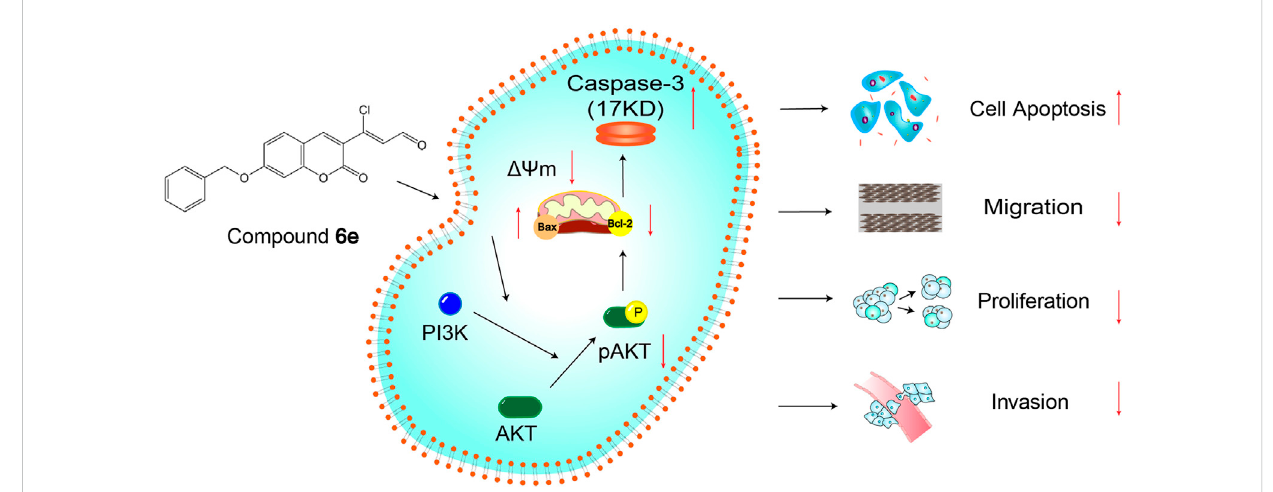
FIGURE 10 Possible mechanism of the antitumor effects of compound 6e